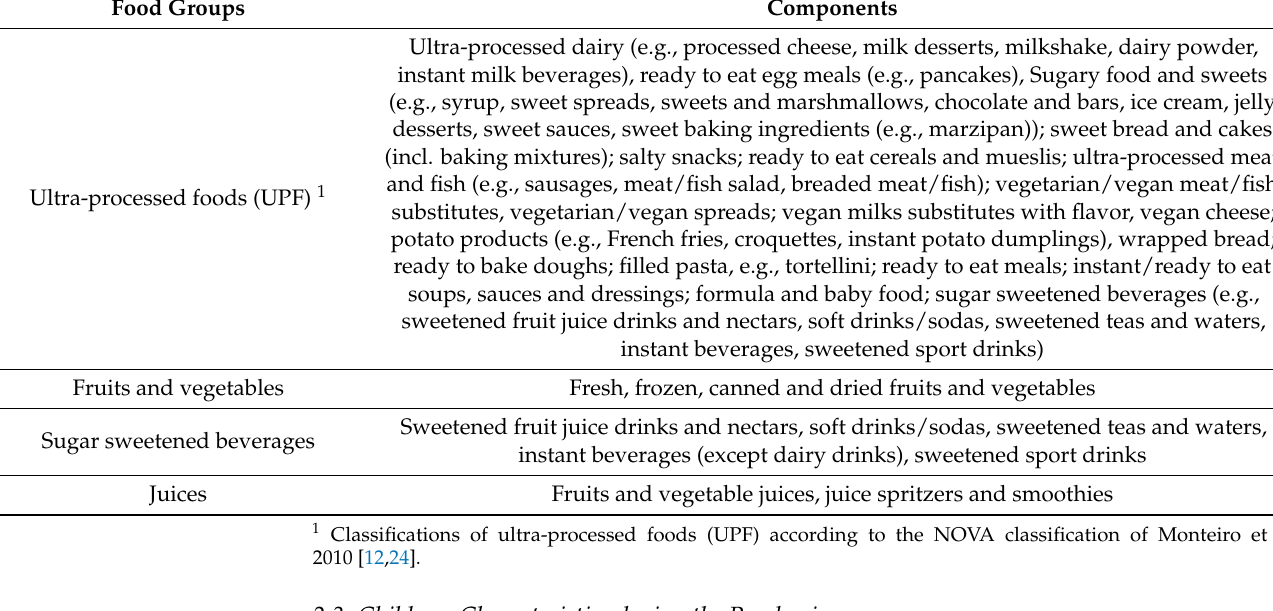
Table 1. Classifications of the food